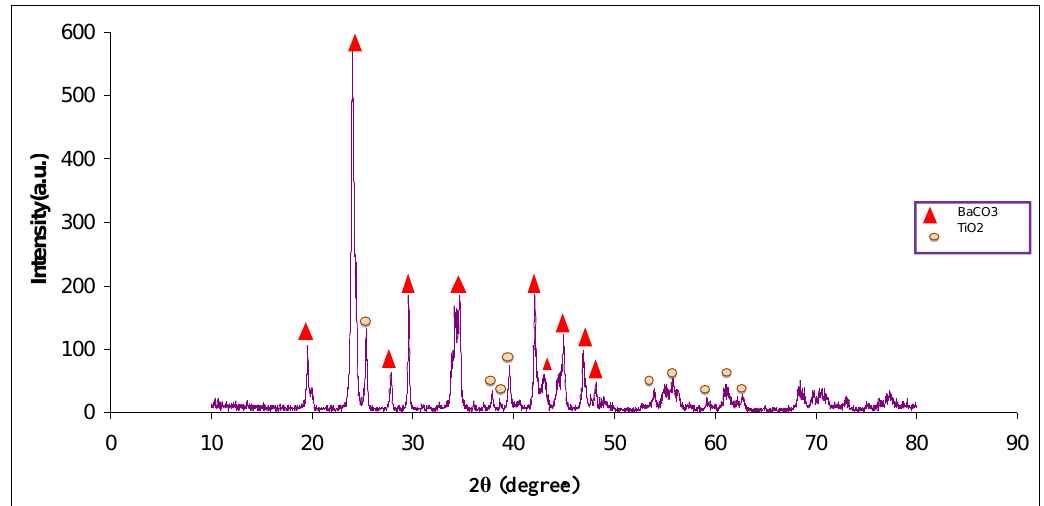
Fig. 3: XRD patterns for Barium Carbonate BaCO